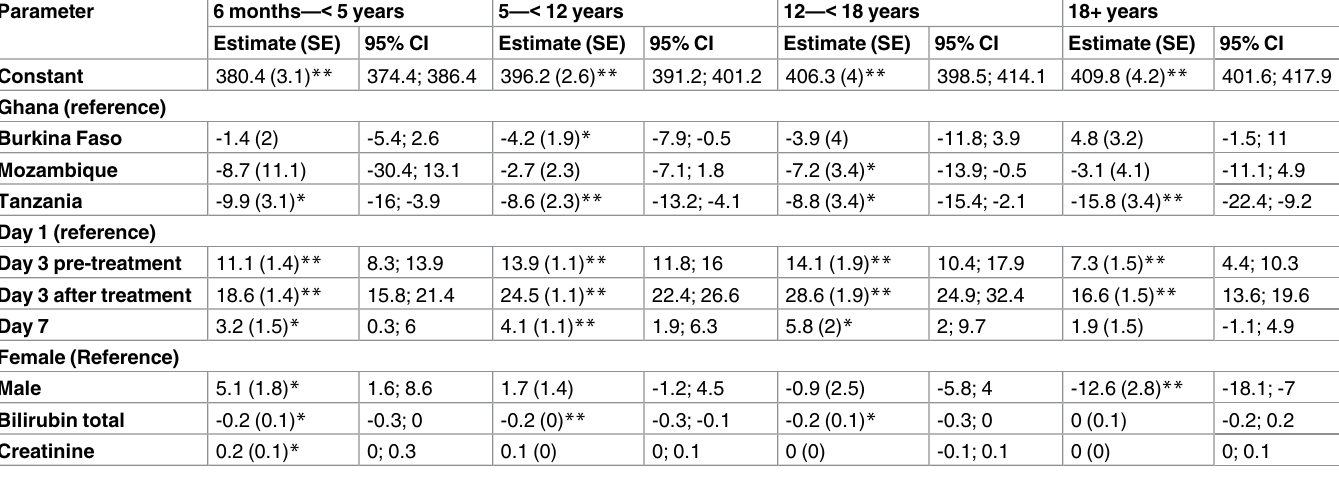
Table 6. Age category based parameterestimatesfrom linear mixed model.